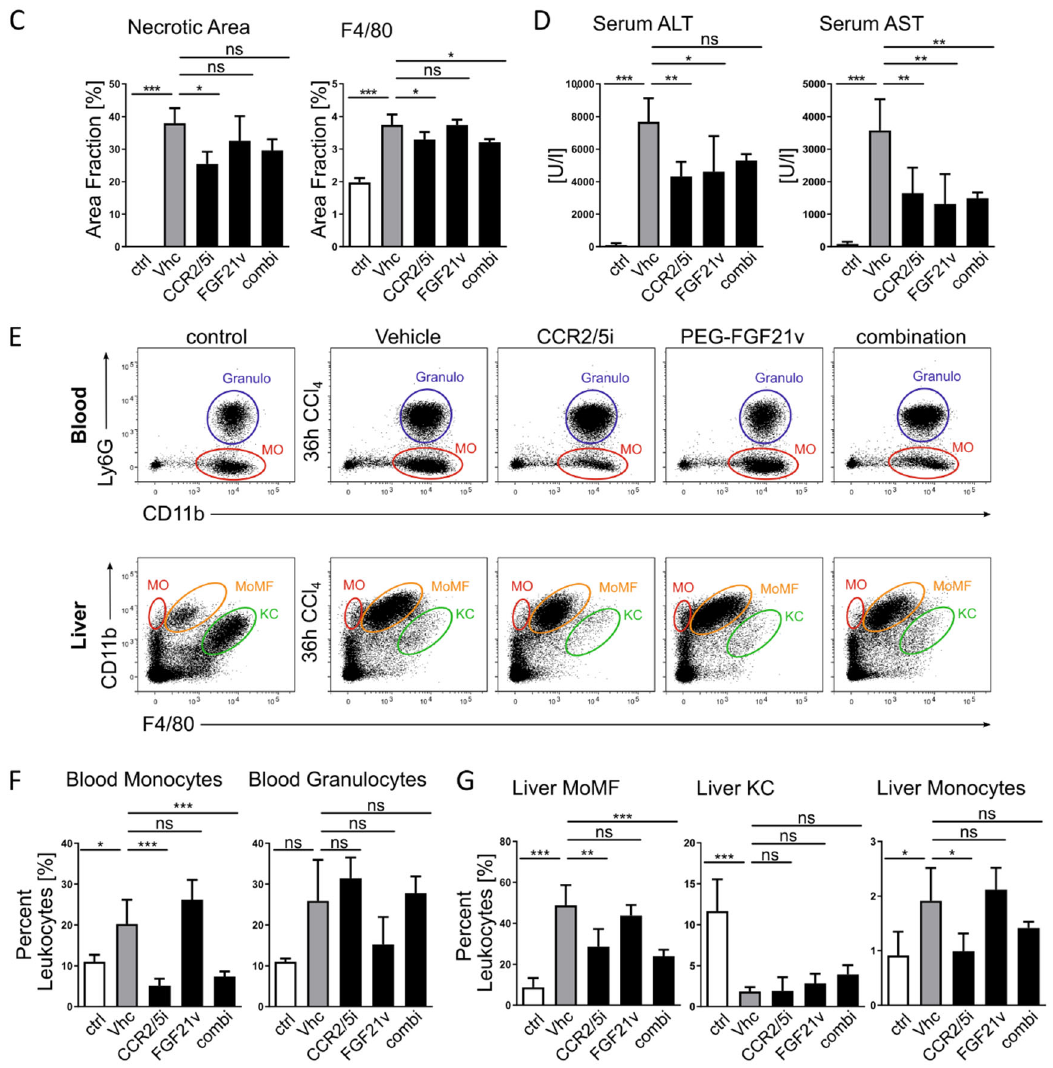
Figure 3. Blocking hepatic infiltration of monocytes and macrophages by CCR2/CCR5 inhibition in acute liver injury. ( A ) Acute liver injury was induced by a single CCl 4 injection. Mice ( n = 4 per group) received vehicle (Vhc), CCR2/CCR5 inhibitor (CCR2/5i) and/or PEG-FGF21 variant (FGF21v). Liver injury and immune cell migration was assessed 36 h after injury induction. ( B ) H&E and F4/80 immunohistochemistry staining of representative liver sections of control and treatments groups ( × 10 magnification; scale bars = 100 µ m). ( C , D ) Quantification of F4/80 positive area fraction. Hepatic injury was assessed by necrotic area fraction and serum alanine (ALT) and aspartate (AST) transaminase levels. ( E – G ) Representative flow cytometric plots of blood (MO = monocytes; Granulo = granulocytes) and liver (MO = monocytes; MoMF = monocyte-derived macrophages; KC = Kupffer cells) immune cell populations and corresponding quantification. Data are presented as mean ± SD ( n = 6–8 per group), ns = non-significant, * p < 0.05, ** p < 0.01, *** p < 0.001 (one-way ANOVA with post-hoc